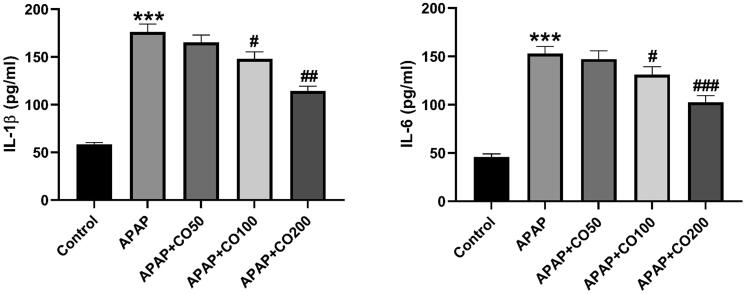
CO attenuates APAP induced activation of inflammatory mediators IL-1β (3) and IL-6 (4) in the kidneys of rats treated with APAP. ELISA results are presented as group Mean ± SEM (n = 6). ***p < 0.001 compared to control group; #p < 0.05 ##p < 0.01and ###p < 0.001, respectively, compared to the APAP group.